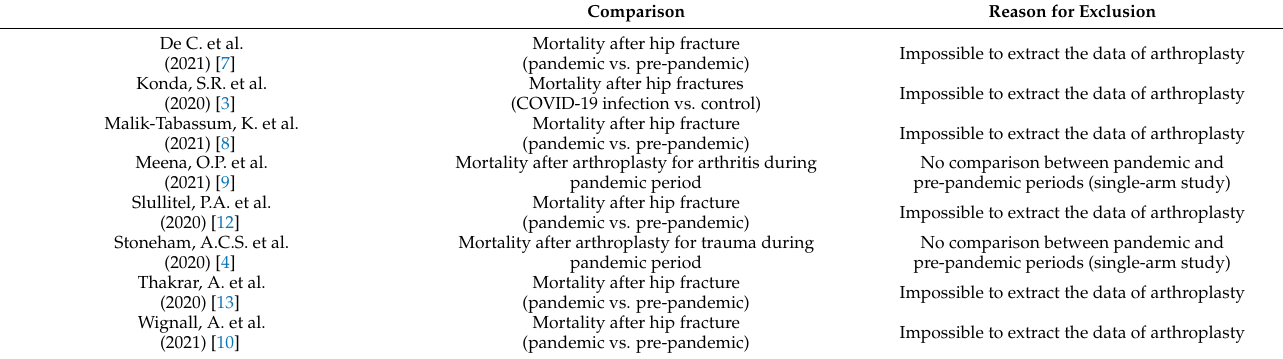
Figure 1. Preferred Reporting Items for Systematic reviews and Meta-Analyses (PRISMA) flow diagram for the process of identifying and selecting the studies included in this meta-analysis. Table 1. Studies that were excluded at full-text review and reasons for